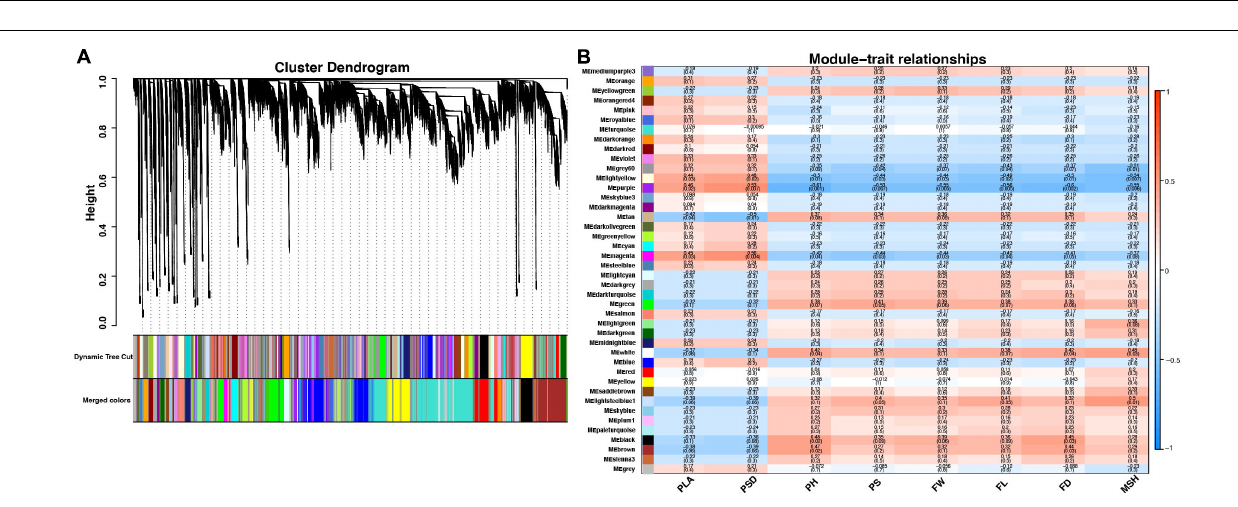
FIGURE 5 | Cluster dendrogram and network heatmap of coexpressed genes. (A) Hierarchical cluster of 42 modules coexpressed genes. (B) Module–trait relationship. Each row represents a module eigengene, and each column presents a trait. Each module includes the corresponding correlation and p -value. PLA, plant leaf area; PSD, plant stem diameter; PH, plant height; PS, plant scope; FL, fruit length; FD, fruit diameter; FW, fruit weight; MSH, main stem